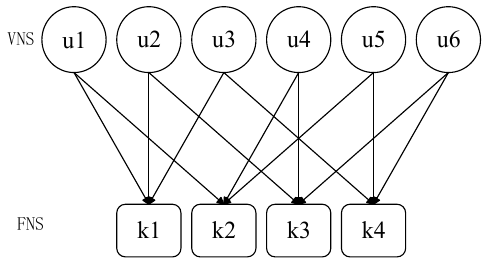
Figure 2. Tanner diagram of codebook (J = 6, k = 4).